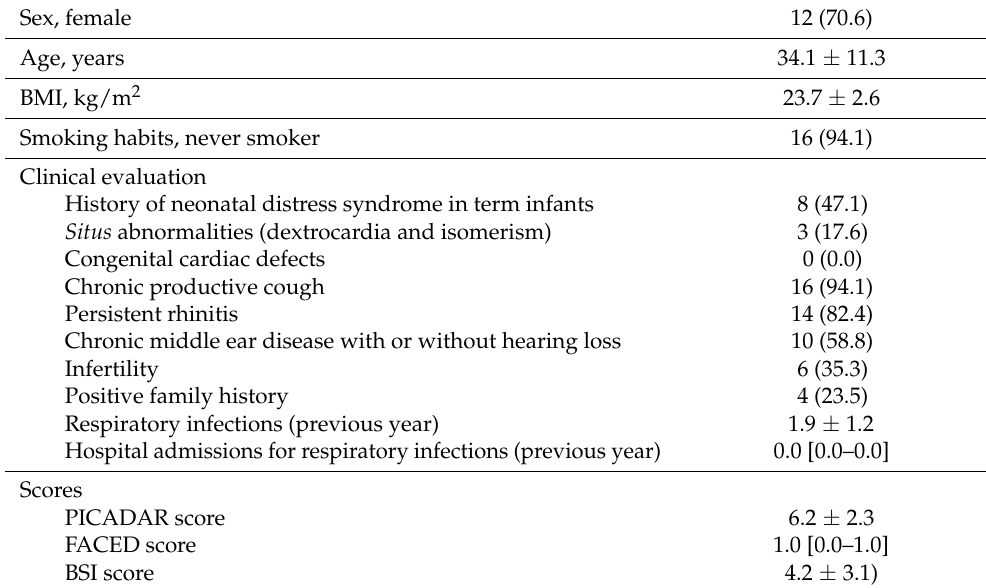
Table 1. Characteristics of patients with primary ciliary dyskinesia at diagnosis. n = 17 (100.0). Sex,